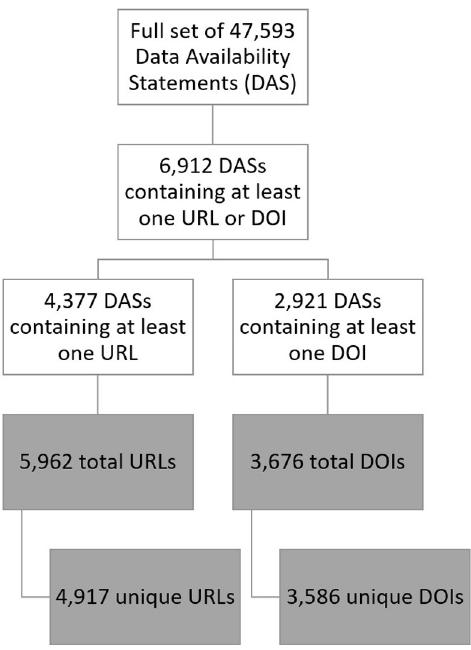
Fig 1. Counts of Data Availability Statements, URLs, and DOIs tested in this